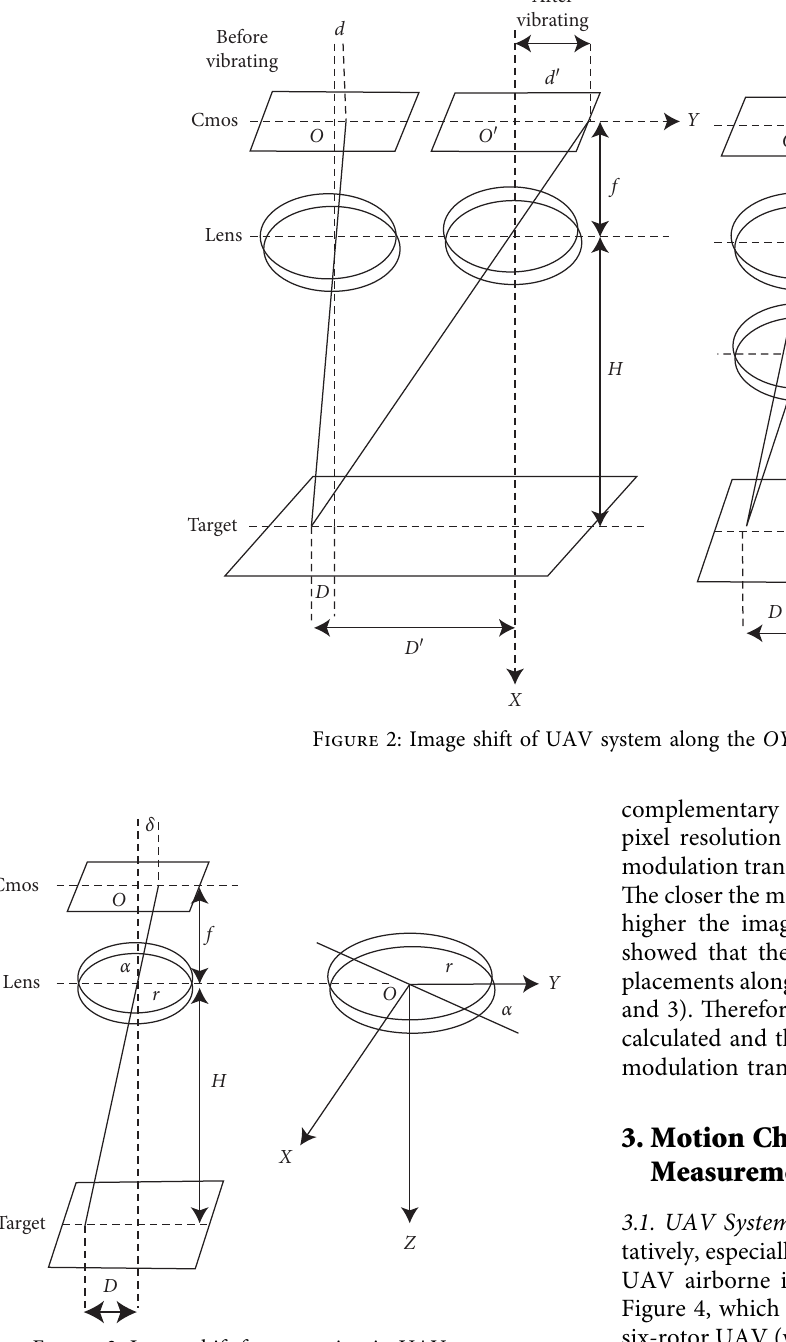
Figure 3: Image shift from rotation in UAV